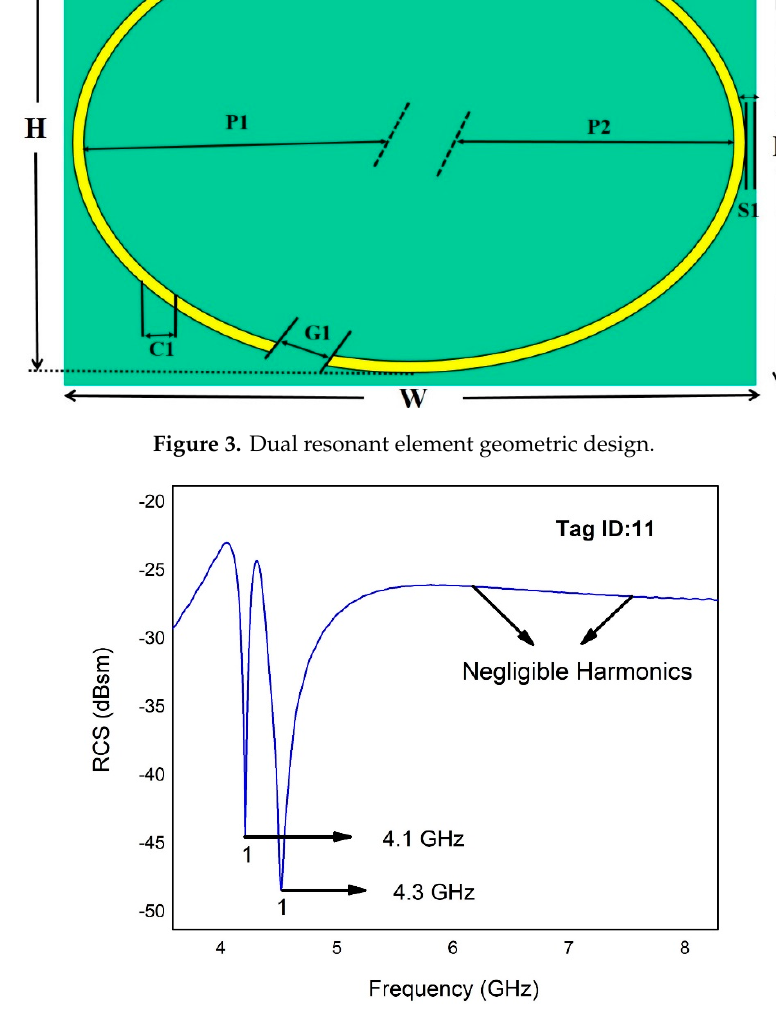
Figure 4. RCS response of dual resonant elements.